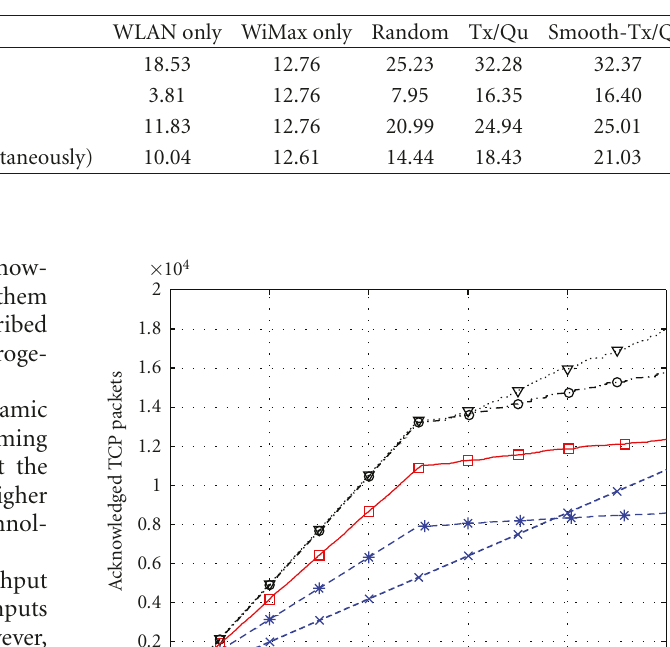
Table 1: TCP level average throughput in Mbps for various distribution schemes in di ff erent conditions. Single user, 1 WLAN AP and 1 WiMax Base Station (BS) colocated. 10 seconds simulated.